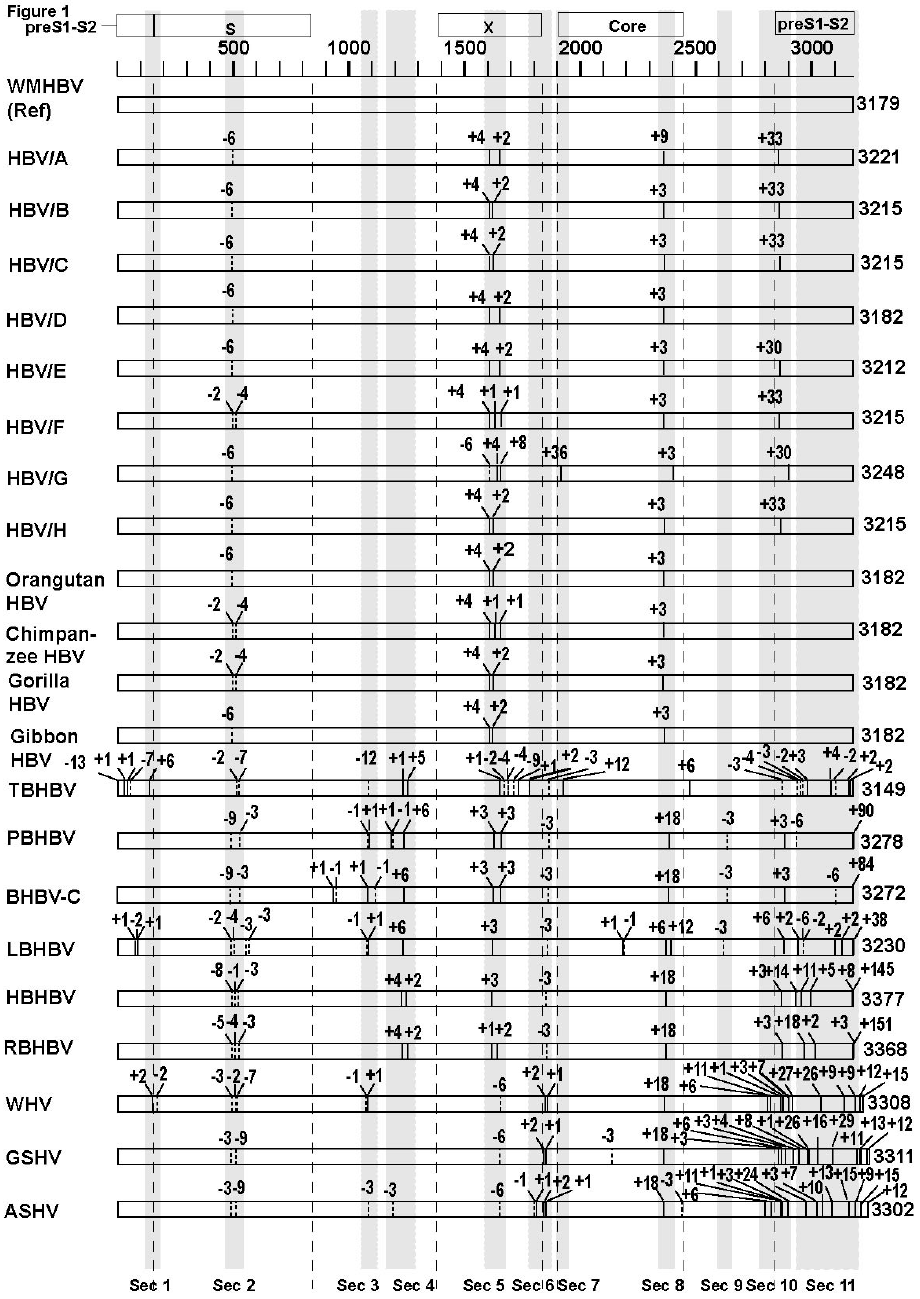
Figure 1. Comparison of sequence gaps. Each full genome sequence of human HBV genotypes A to H, primate HBVs (orangutan, chimpanzee, gorilla, and gibbon), bat HBVs (TBHBV, PBHBV, BHBV-C, LBHBV, HBHBV, and RBHBV), and rodent HBVs (WHV, GSHV, and ASHV) was aligned with the reference sequence of WMHBV (AF046996). Sequence gap positions and gap lengths (insertion, +; deletion, -) are shown. Areas with frequent sequence gaps among species are shown in shaded rectangles and named Sec 1 to Sec 11. Sec, section.